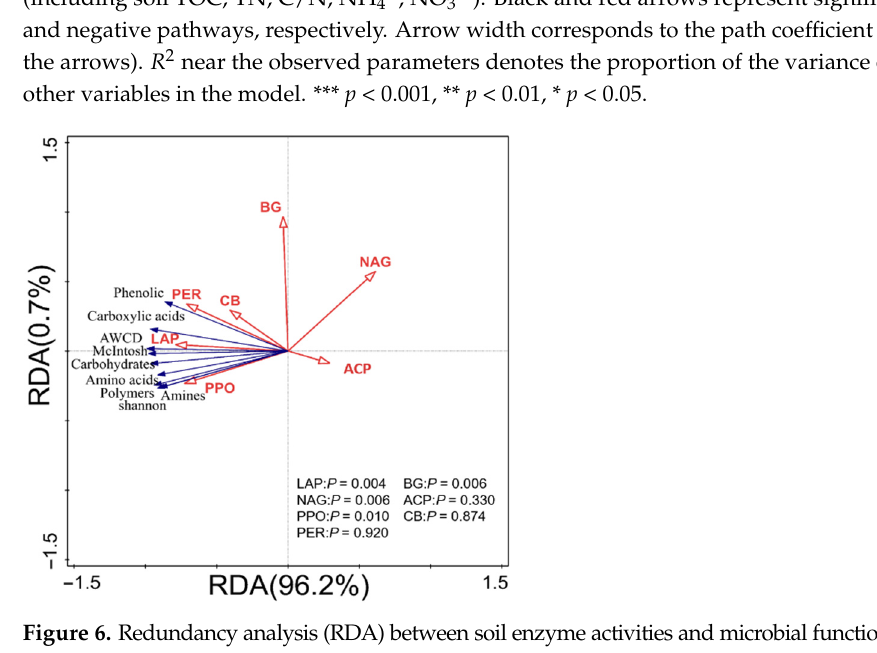
Figure 5. ( A ) Relationships between the enzyme-related parameters and the CLPP-related parameters. ( B ) Pearson correlations among edaphic and environmental factors. Microbial function and enzyme activities were linked to each factor by Mantel tests. Links width is proportional to Mantel’ r, and link color signifies the level of significance. ( C ) The structural equation model (SEM) shows the potential causal relationships among soil-plant properties and microbial parameters.